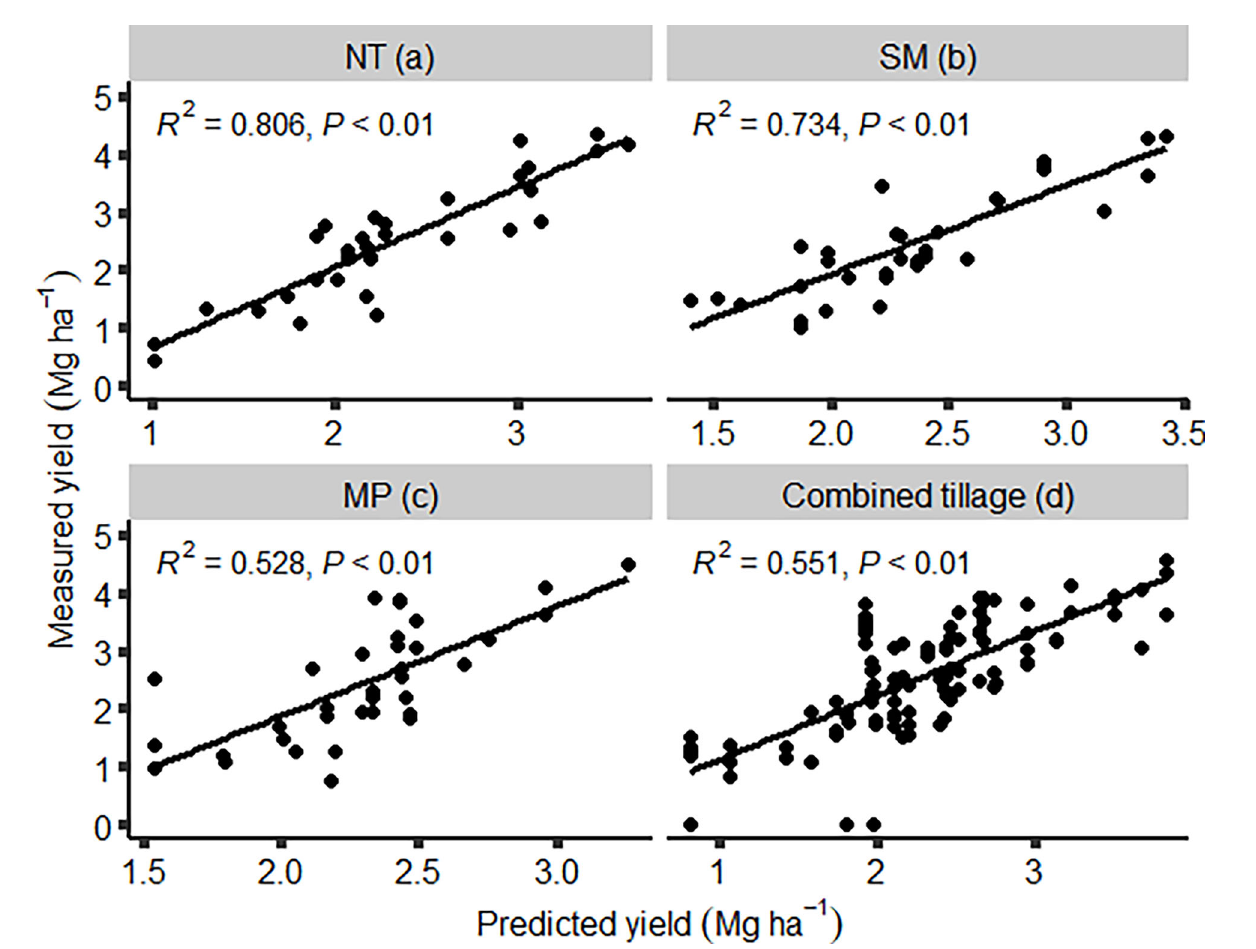
FIGURE 2 The relationship between predicted grain yield and measured grain yield for winter wheat. The prediction was done by fi tting and validating a feed- forward neural network model under different tillage practices using precipitation received at three different periods of the season. The tillage practices were NT (A) , SM (B) , MP (C) , and combined tillage (D) . NT, no-till; SM, stubble mulch; MP, moldboard plow.